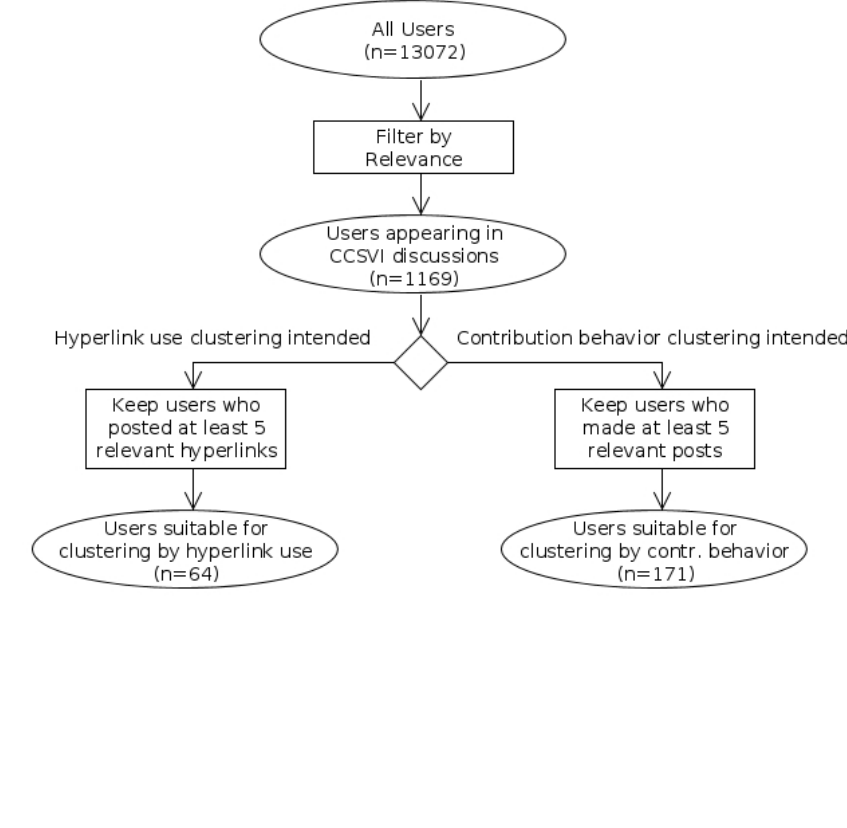
Figure 3. Flowchart of the sampling procedure for